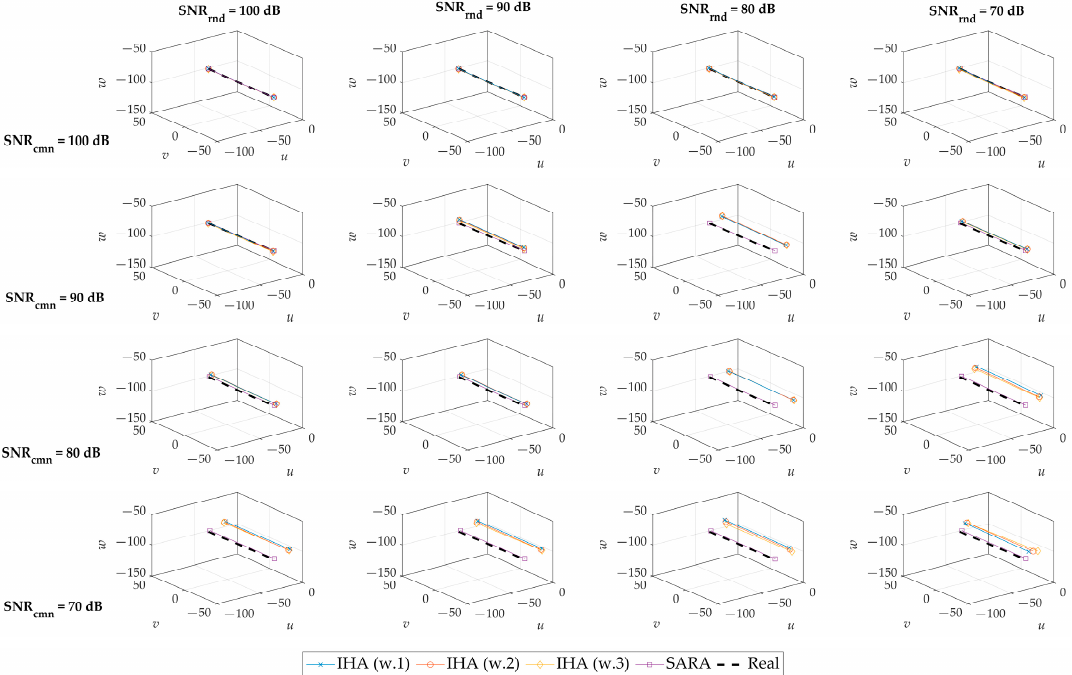
Figure 8. AoRs calculated with MHA, by choosing different weighting factors, and SARA, for motion configuration A. Each row and column correspond to a particular level of common and random noise signals, in terms of signal-to-noise ratios. The exact AoR imposed by joint kinematics setup is highlighted in dashed black line. All axes units are in mm.